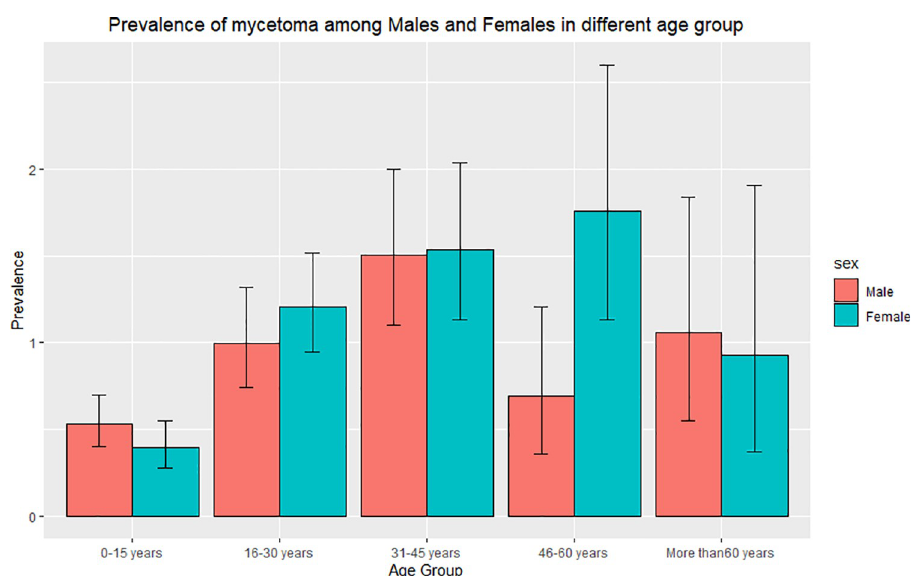
Fig 4. Bar plot of the prevalence of mycetoma among different age groups according to gender. Males had a higher prevalence among the age groups 0–15 years and more than 60 years, and females recorded a higher prevalence among the other age